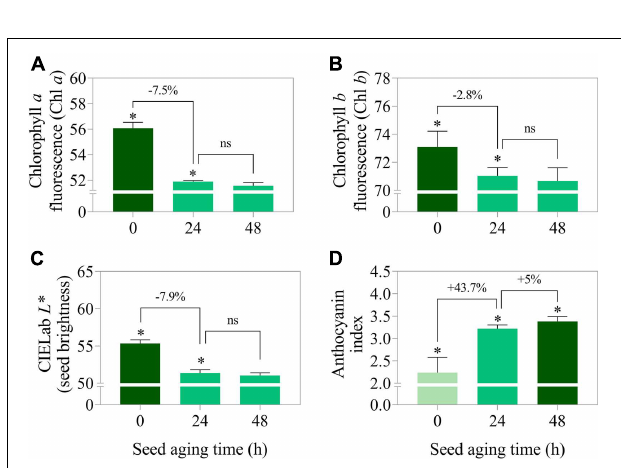
FIGURE 5 | Chlorophyll a fluorescence at excitation/emission combination of 630/700 nm (A) , chlorophyll b fluorescence at excitation/emission combination of 405/600 nm (B) , CIELab L ∗ representing the perceived brightness ranging from 0.0 (black) to 100.0 (white) (C) , and anthocyanin index (D) in peanut seeds ( Arachis hypogaea L.; cv. IAC OL3) from lot 7 artificially aged for 0, 24, and 48 h. Means ( ± standard deviation); significant ( ∗ ); not significant (ns); (p > 0.05) ( n =